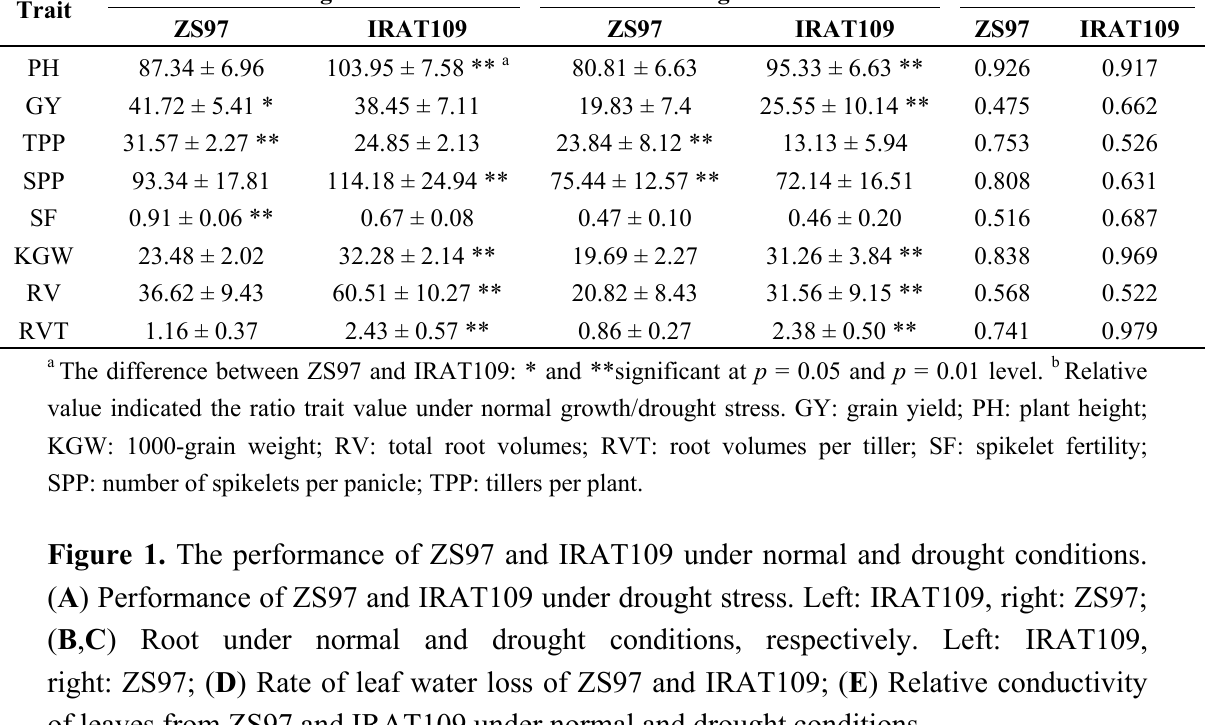
Table 1. Phenotypic difference of ZS97 and IRAT109 under natural and drought stress. Normal growth Drought stress Relative value b Trait ZS97 IRAT109 ZS97 IRAT109 ZS97